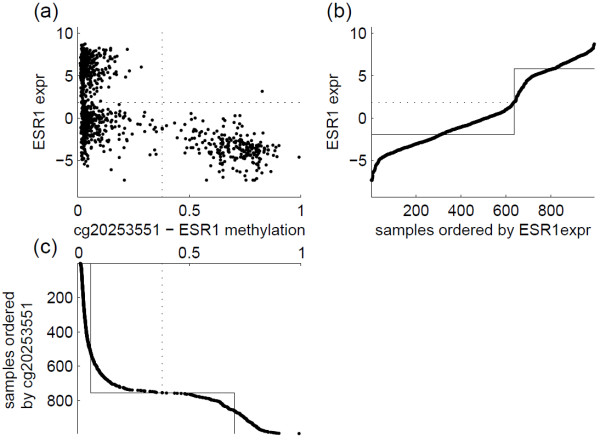
Two examples of univariate StepMiner. (a) Scatter plot of ESR1’s gene expression and methylation (cg20253551). The dotted lines indicate thresholds identified by StepMiner. (b) Samples are ordered according to ESR1 expression, and a step function is fitted to the ordered expression data and identify a threshold to dichotomize expression. (c) A step function is fitted to the ordered methylation data and identify a threshold to binarize methylation.